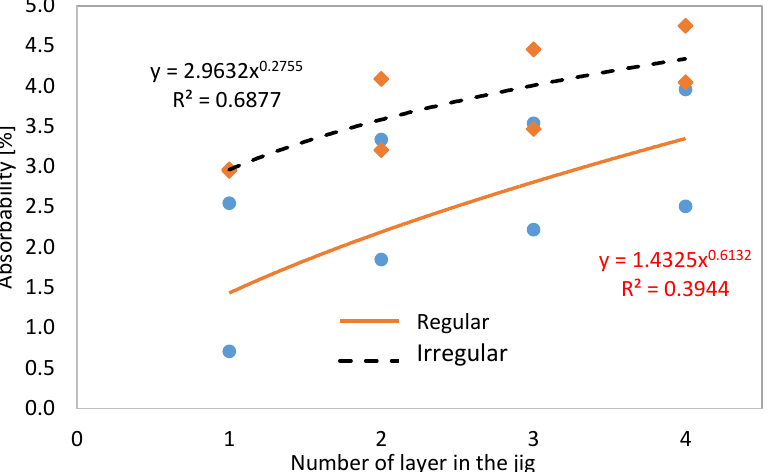
Figure 8. Model of separation density calculated separately for regular and irregular particles.